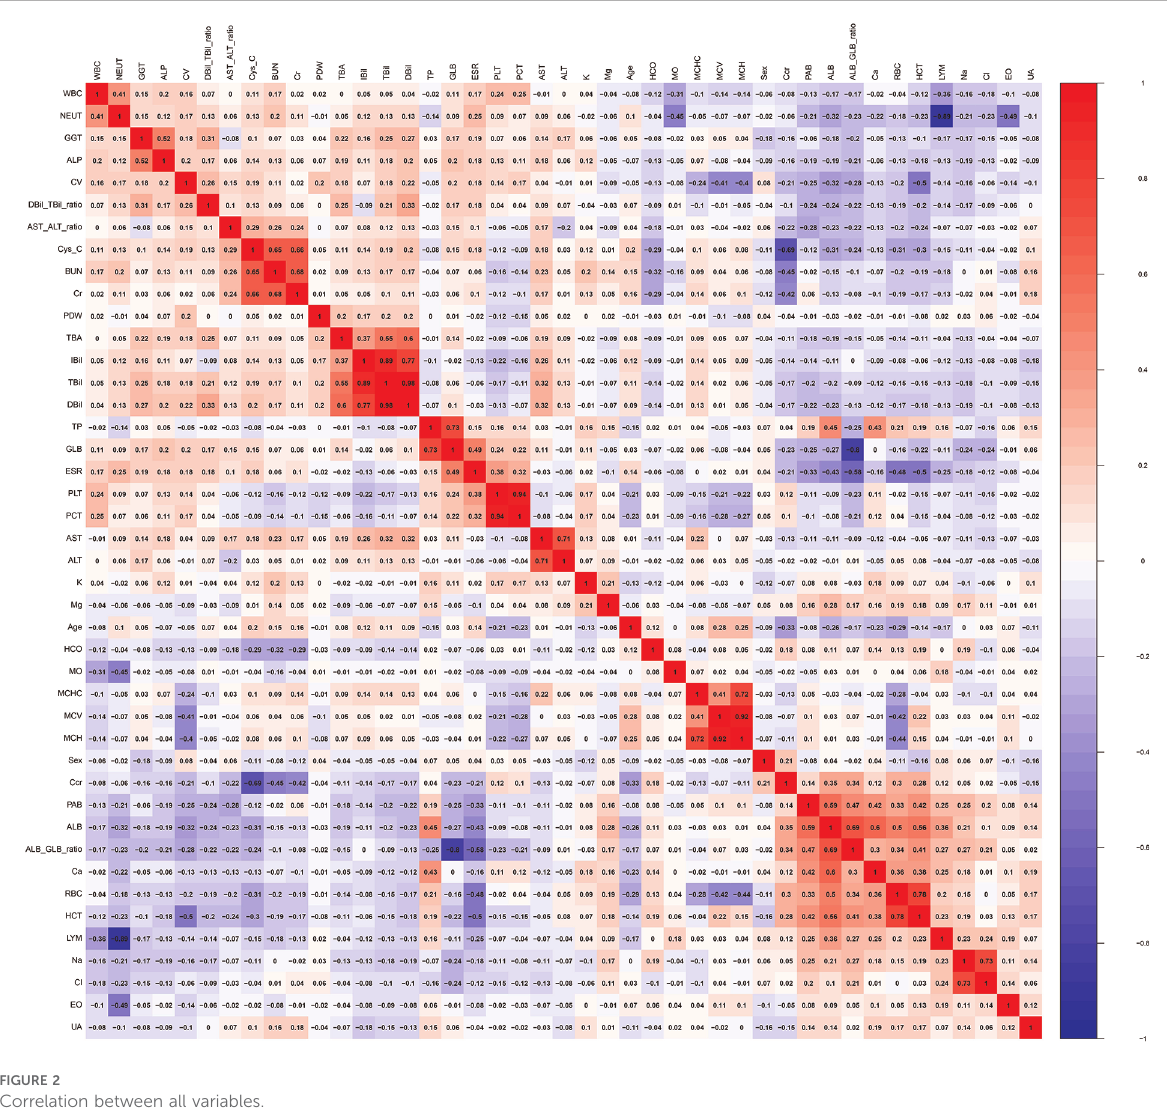
regression to screen out fi ve factors as the fi nal model ( Figure 5 ). The fi nal fi ve factors screened were PDW, LYM, AST/ALT, BUN, and Na + .